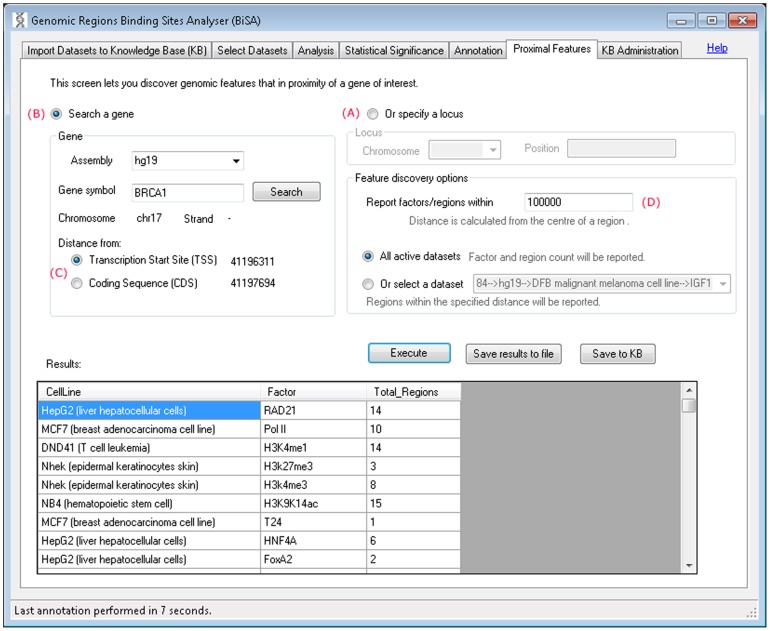
Proximal features.This tab allows users to search for genomic features located in proximity to a specific gene or genomic locus. Searching multiple datasets returns the numbers of binding sites for each factor identified. Selecting a single factor returns detailed binding region information for interactions in proximity to the gene or locus of interest.